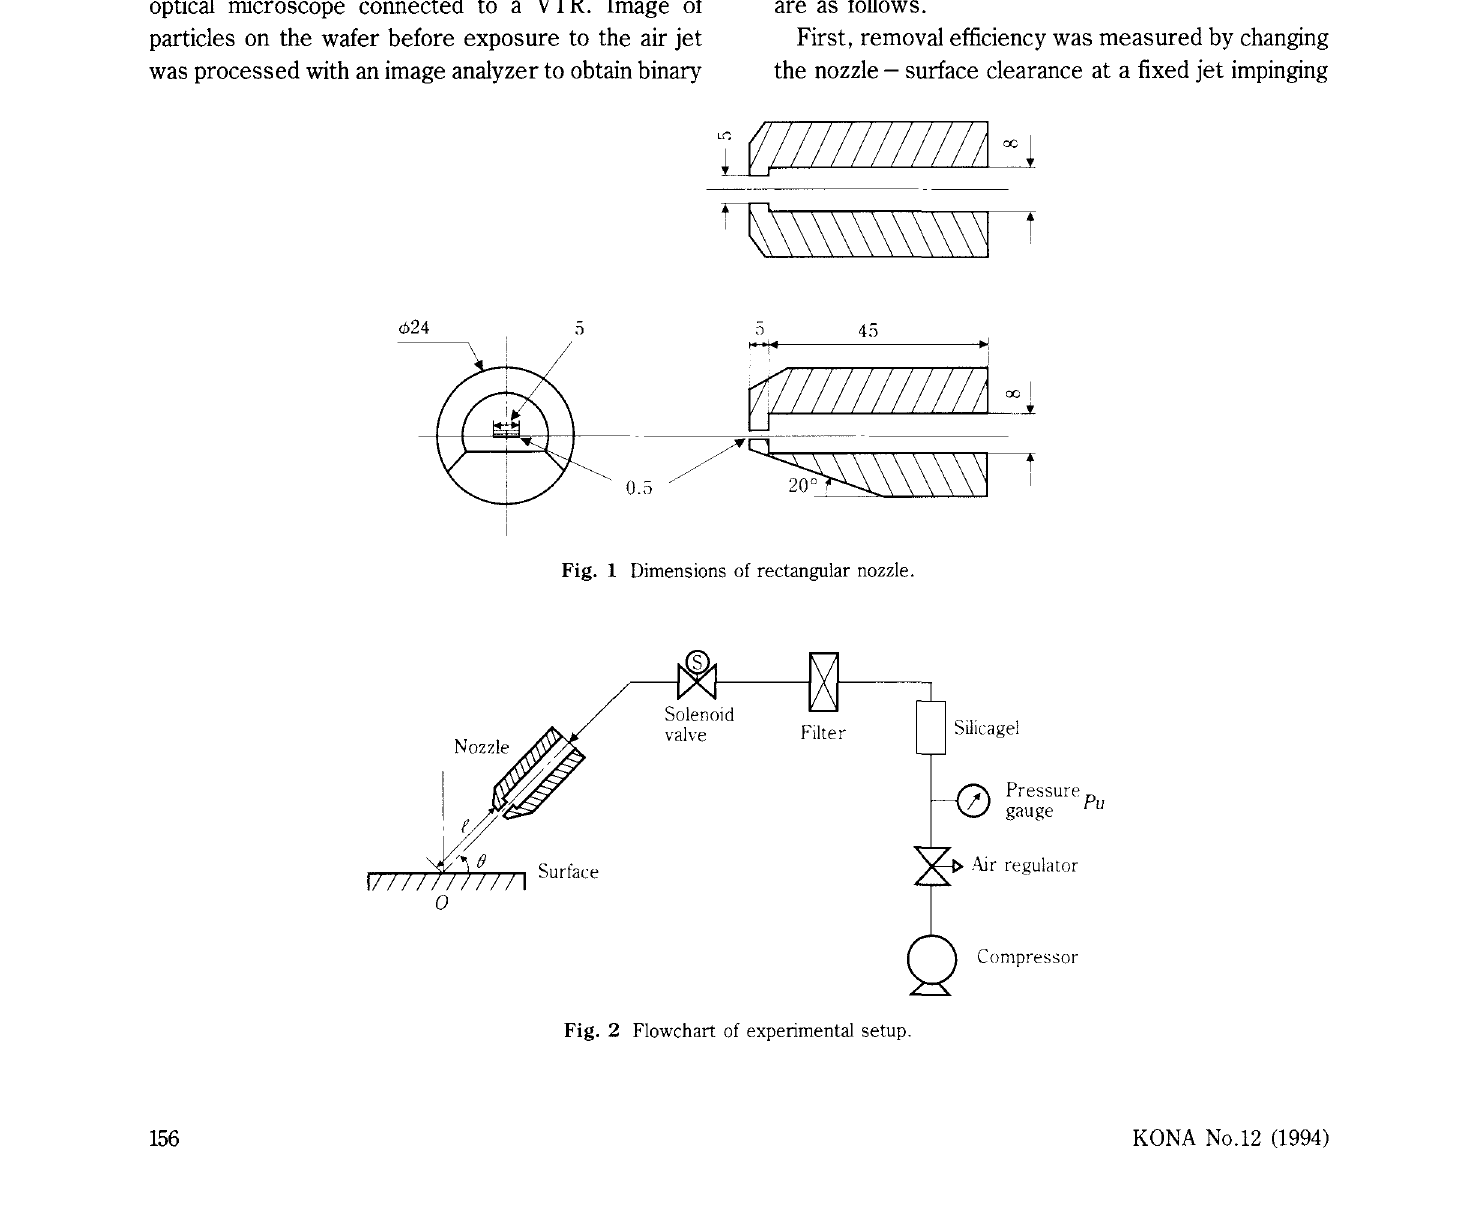
Fig. 2 Flowchart of experimental